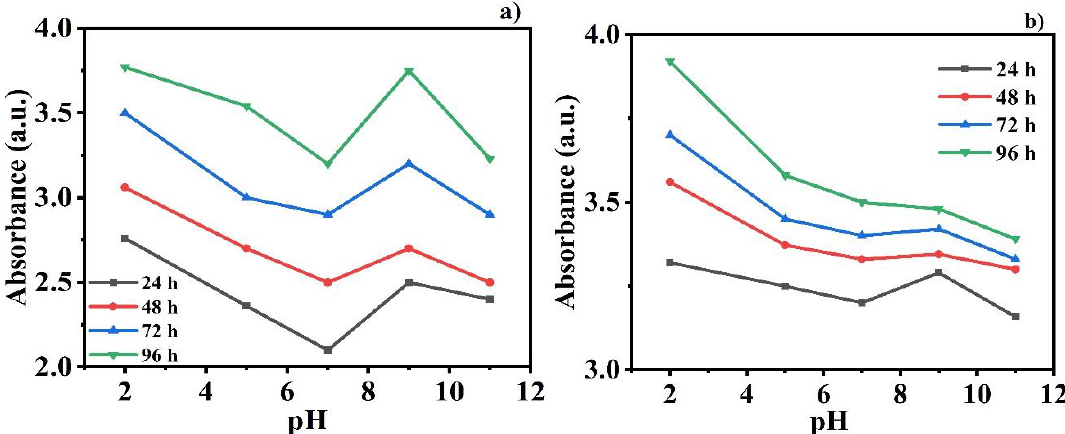
Figure 6. UV-vis analysis of ( a ) CeO 2 / NMTU and ( b ) CeO 2 / DDA after di ff erent time intervals of immersion in 3.5 wt.% NaCl solution at di ff erent pH values.